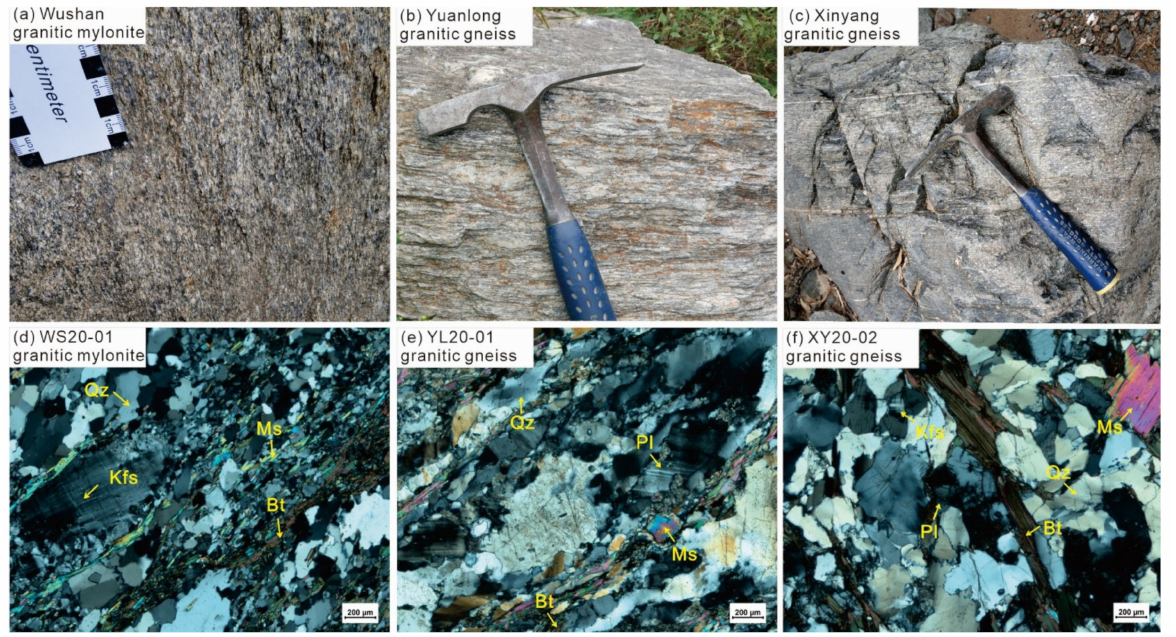
Figure 3. Field photographs ( a – c ) and photomicrographs ( d – f ) of granitic mylonites and granitic gneisses from the Wushan, Yuanlong, and Xinyang areas. Qz—quartz;